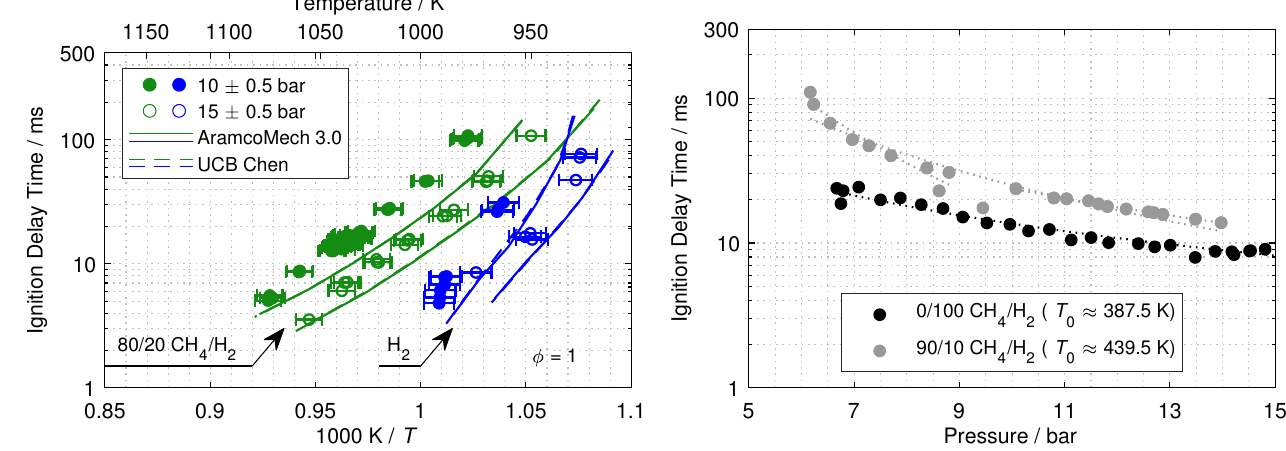
Figure 5. ( Left ): Comparison of a stoichiometric H 2 mixture (bullets) vs. stoichiometric 80/20 CH 4 /H 2 mixture (open circles) at pressures of 10 ± 0.5 bar and 15 ± 0.5 bar. Simulations: AramcoMech 3.0 [68] (full lines) and UCB Chen [69] (dashed lines). ( Right ): IDT experiments of two fuels with a constant initial temperature and varying pressure. Lines are drawn to guide the